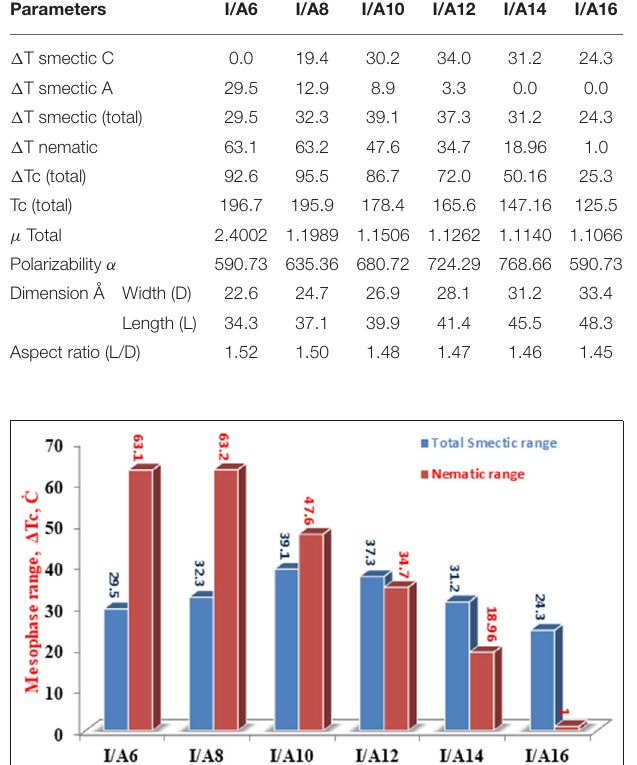
TABLE 3 | Dipole moment ( µ ), polarizability ( α ), and aspect ratios ( L/D ) of SMHBCs, I/A n . Parameters